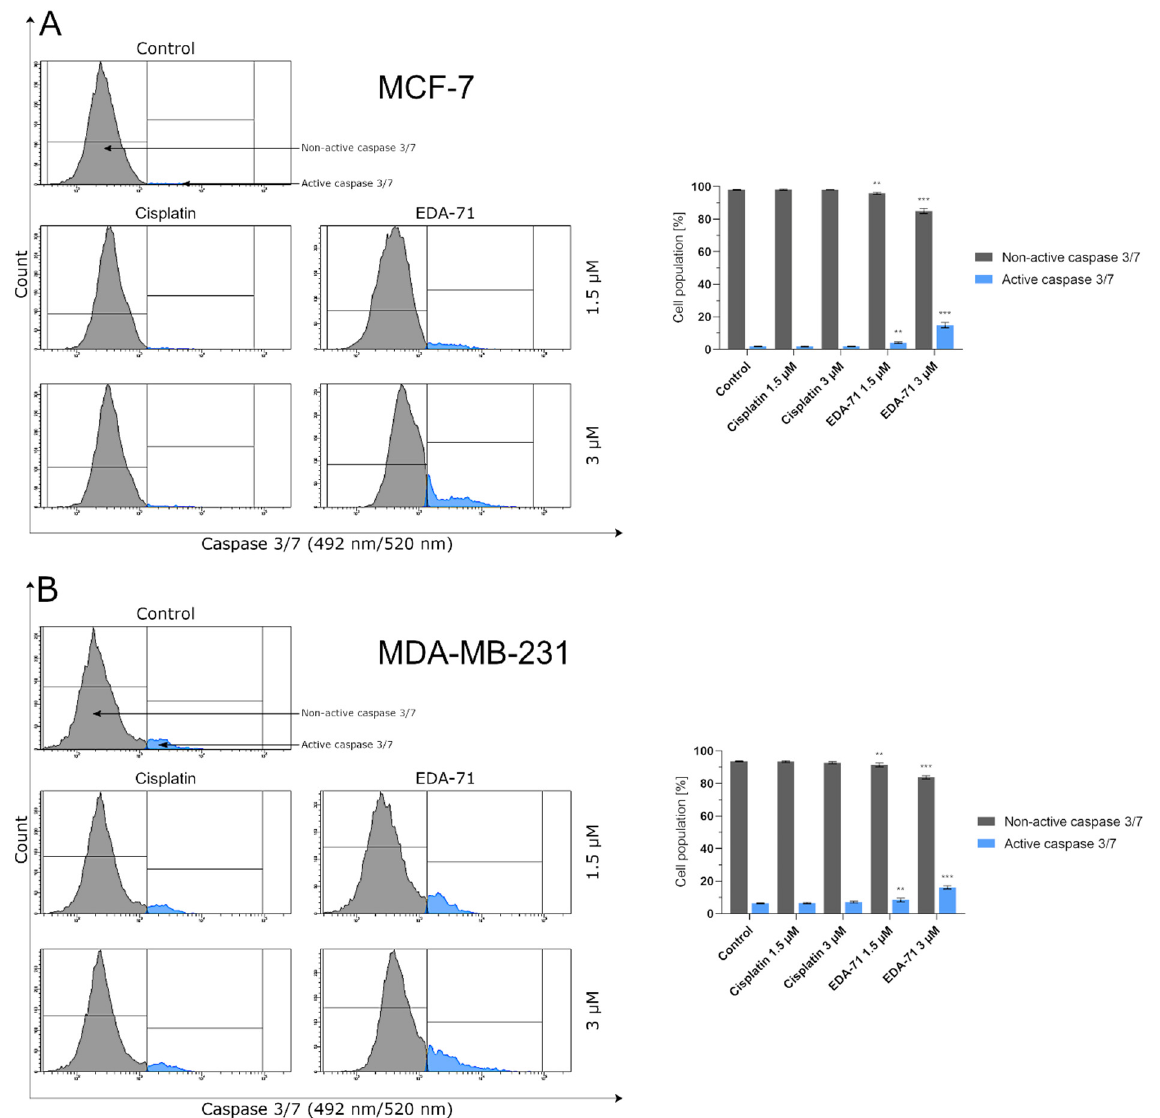
Figure 10. Cytometric analysis of caspase 3/7 activity in MCF-7 ( A ) and MDA-MB-231 ( B ) breast cancer cells after 24 h incubation with EDA-71 and cisplatin (1.5 and 3 µM). Results are presented as mean values ± SD obtained from three independent experiments ( n = 3) conducted in triplicate. Statistical differences between the experimental (treated cells) and control (untreated cells) groups were determined using one-way ANOVA followed by Dunnett’s test. ** p < 0.01 vs. control group, *** p < 0.001 vs. control group.